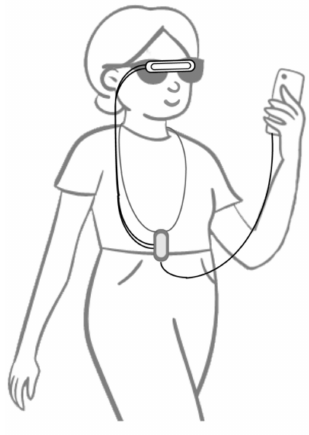
Figure 2. Object detection, recognition and navigation system